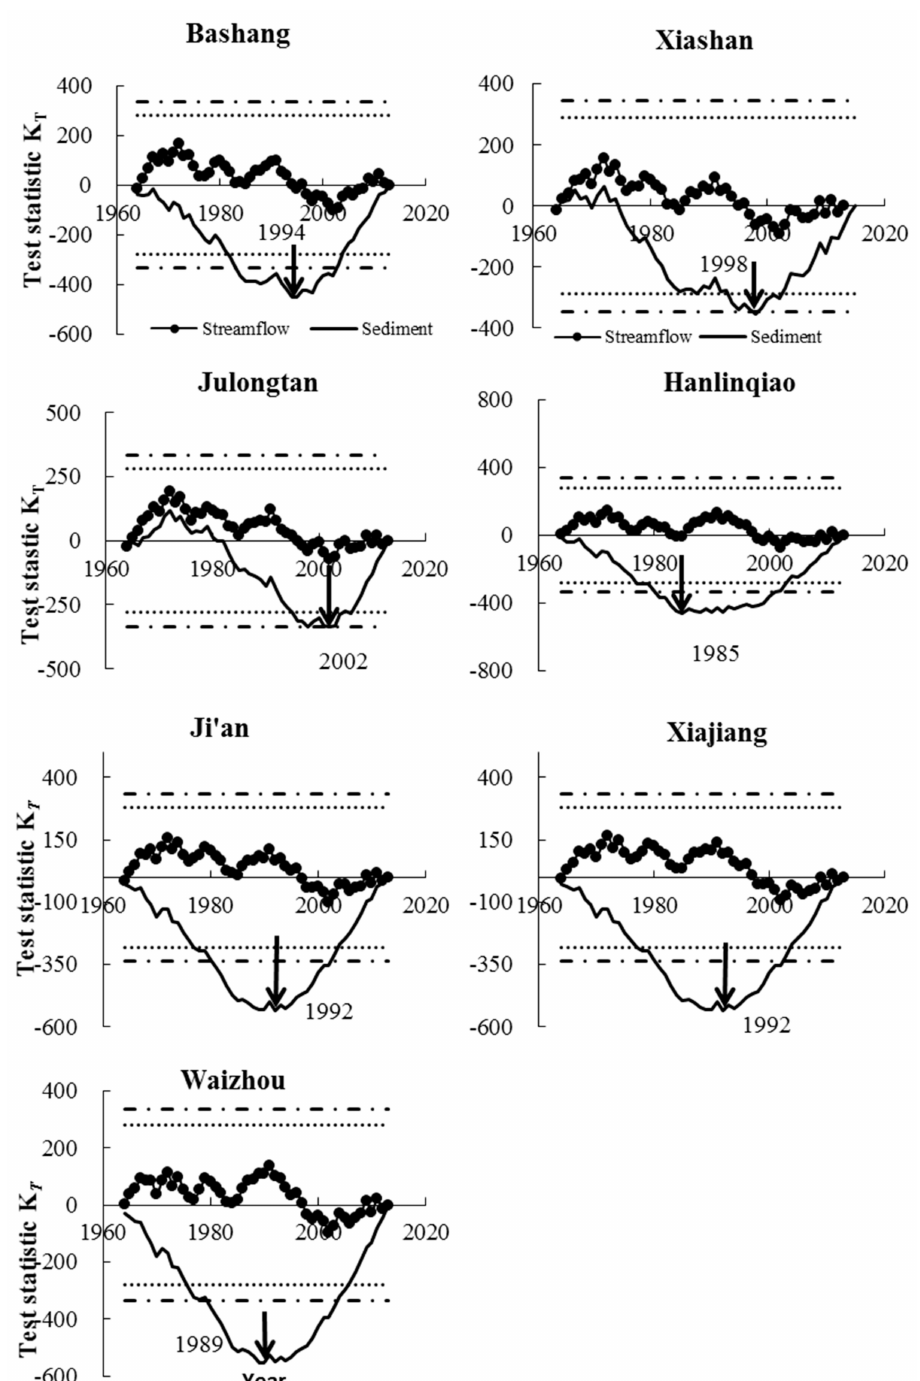
Figure 3. Pettitt’s test K T statistic used for detecting a change point in annual sediment discharge of hydrological stations during 1964–2013 on the Ganjiang River basin. Note: The black arrow indicates the change-point year, and the horizontal lines represent the significance levels of 99% (dotted) and 95% (dash-dot),